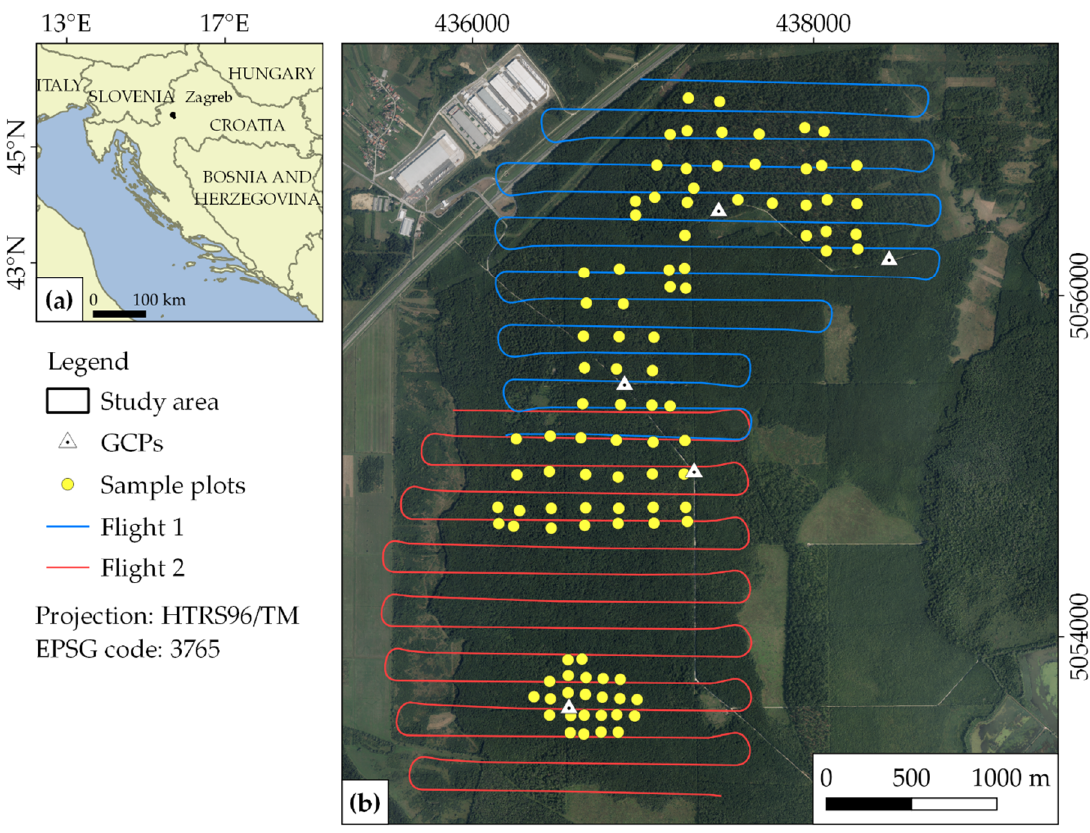
Figure 1. The small map ( a ) displays the location of the study area in Croatia. The main map ( b ) presents the study area in more detail with spatial distribution of sample plots (yellow circles), Ground Control Points (GCPs) (white triangles), and flight paths of the first (blue line) and second (red line) flights (background: orthophoto of aerial images from summer 2015).